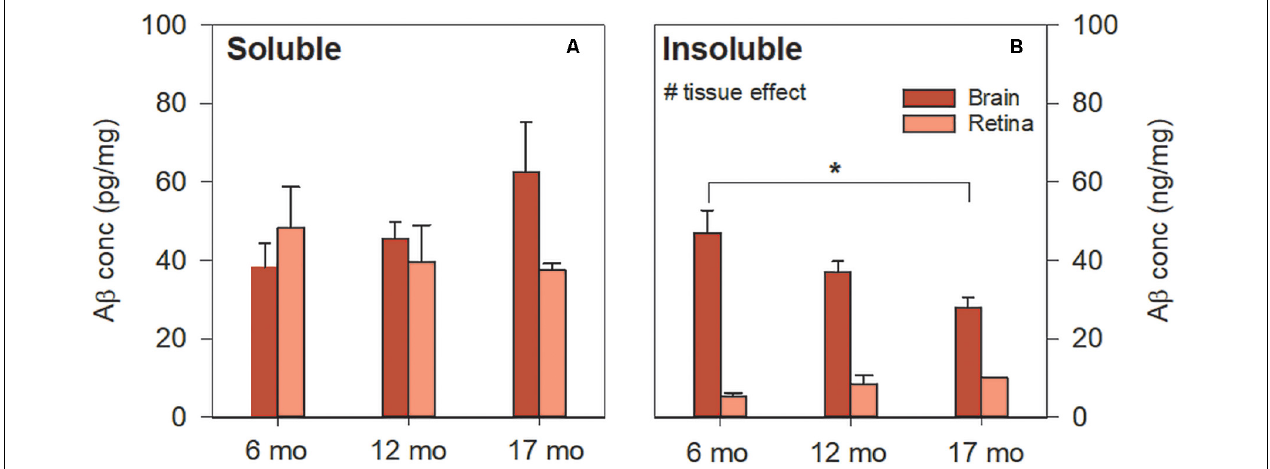
FIGURE 3 | A β levels in 5xFAD brain and retina using ELISA. (A) Soluble A β in the brain increased with age but remained unchanged in the retina with age. Soluble A β levels in the retina were comparable to that of the brain. (B) Insoluble A β levels in the retina were lower than that of the brain. A β was not detected in WT mice (not shown). Bars, Mean ± SEM; # p < 0.05 for tissue effect on two-way ANOVA analyses. * p < 0.05 for Bonferroni post hoc